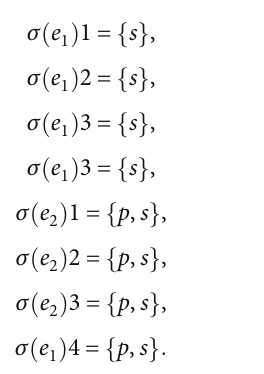
Table 36: Intuitionistic fuzzy set B